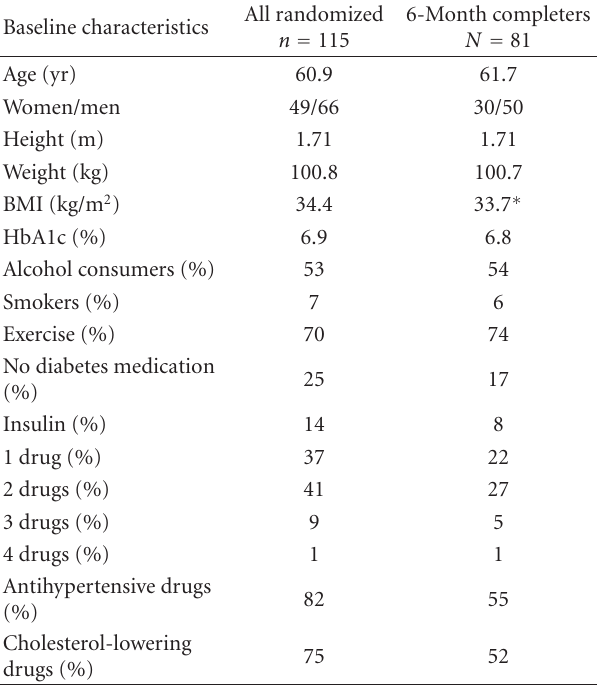
Table 1: Baseline characteristics of subjects enrolled and subjects who completed 6 months.